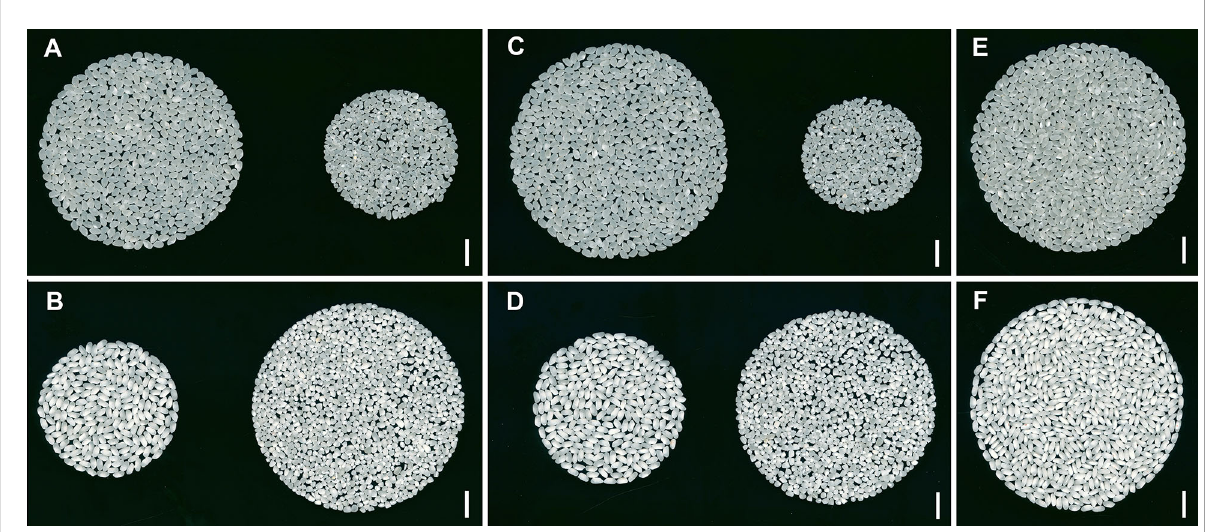
FIGURE 3 Phenotypes of milled rice from Koshihikari and Nona Bokra. (A, B) The whole grain appearance of Koshihikari (A) and Nona Bokra (B) . Whole grains are on the left, and broken grains are on the right. (C, D) The head rice appearance of Koshihikari (C) and Nona Bokra (D) . Head rice grains are on the left, and non-head rice grains are on the right. (E, F) The difference in chalkiness between head rice from Koshihikari (E) and Nona Bokra (F) . Scale bar: 1 cm.